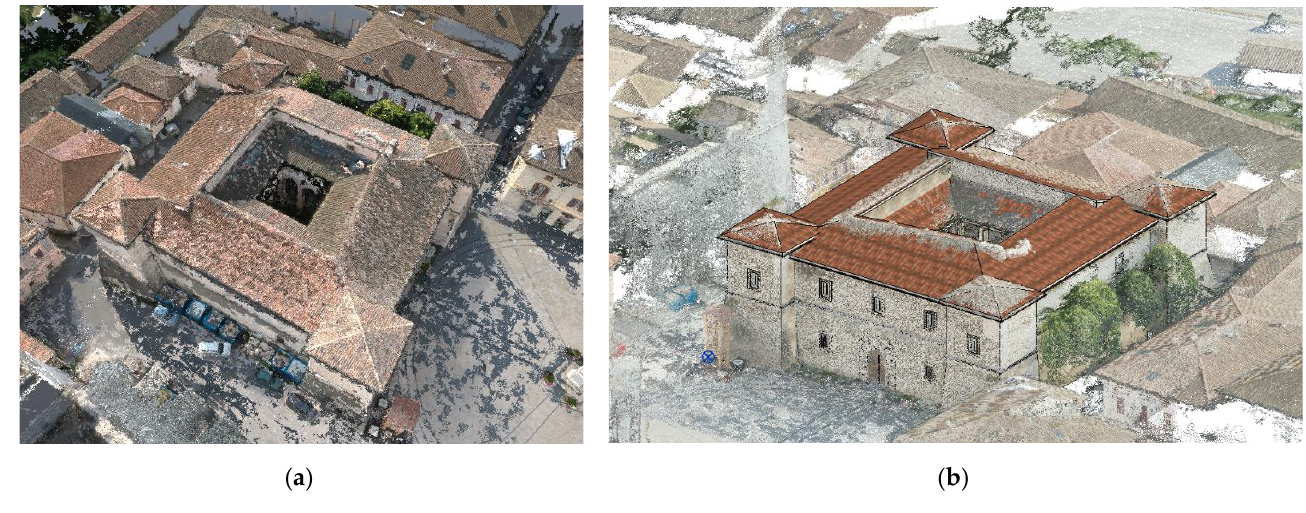
Figure 11. Examples of volumetric high scale 3D data: point cloud ( a ), and ( b ) models for Castellina building in Norcia.